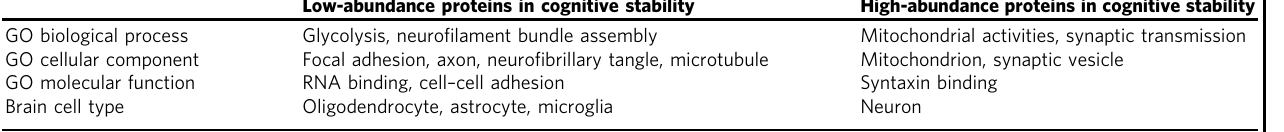
Table 3 Gene ontology and cell type enrichment analyses of cognitive trajectory-associated proteins adjusting for